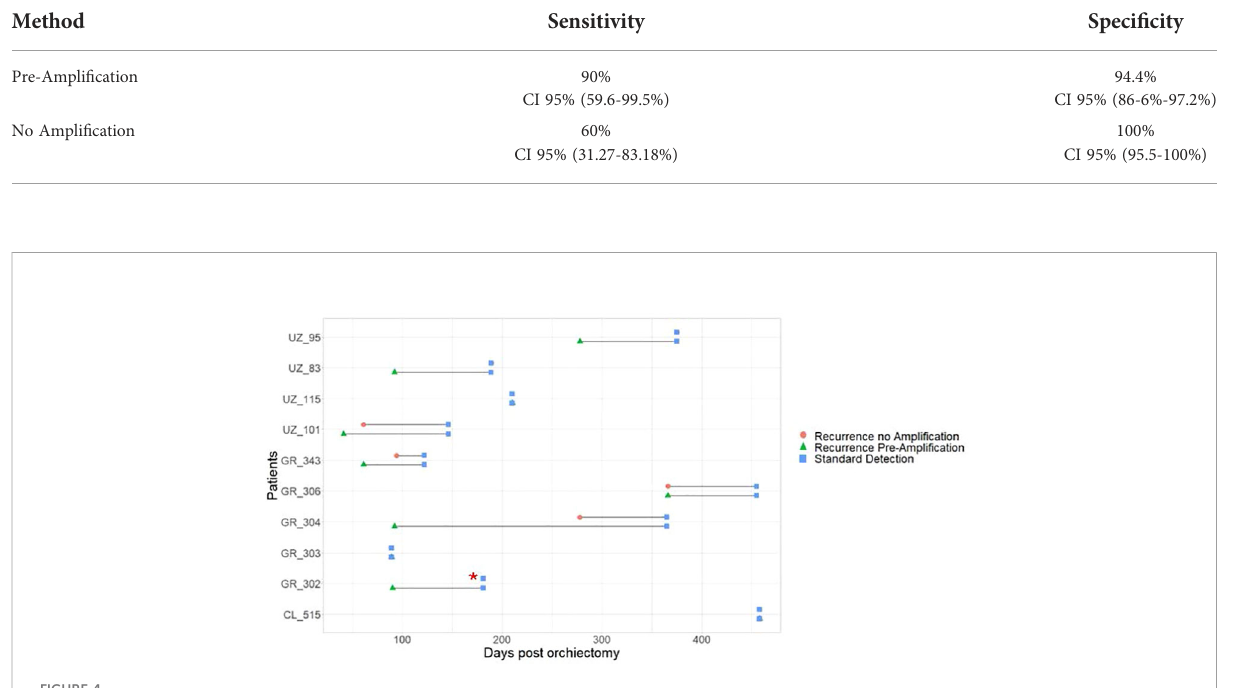
FIGURE 4 Comparison of recurrence detection during active surveillance of Stage I TGCT patients. Data shown compares the time of recurrence as detected via elevated serum MiR-371a-3p (Fold Change) via Non-Ampli fi ed (Red circle), Pre-Ampli fi ed (Green triangle) and via current parameters established in clinical practice (Blue square) post orchiectomy. Red asterix (*) indicates recurrence was not detected in known recurrence patient when using non-ampli fi ed protocol.